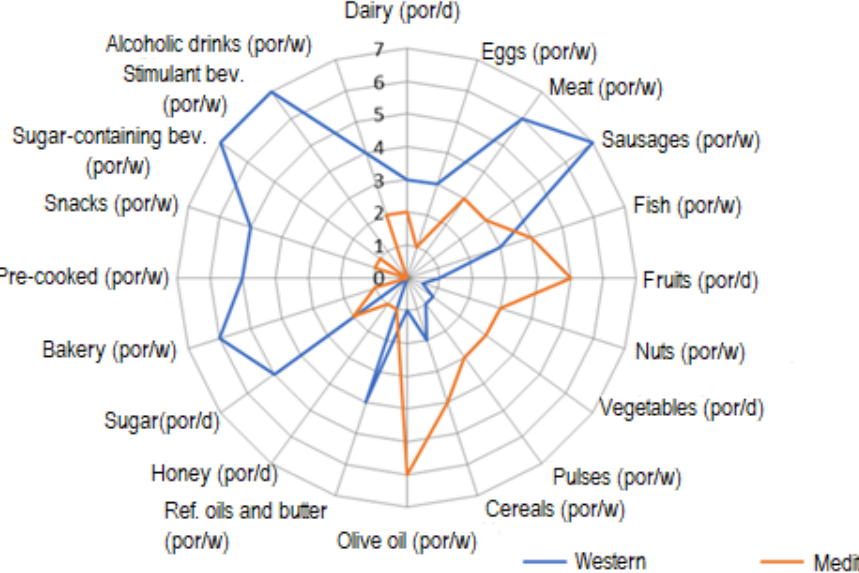
Figure 1 represents the medians of consumption portions (expressed per day or per week, pursuant to the recommendations for the Spanish population) of the different food groups for certain dietary patterns.